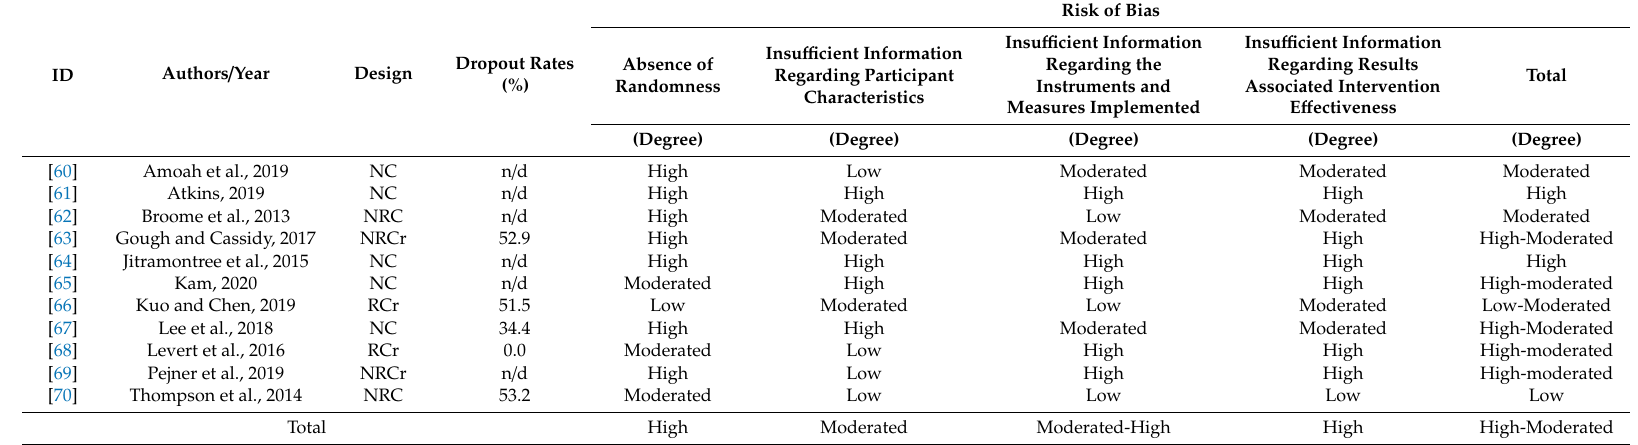
Table 4. Risk of bias in the included